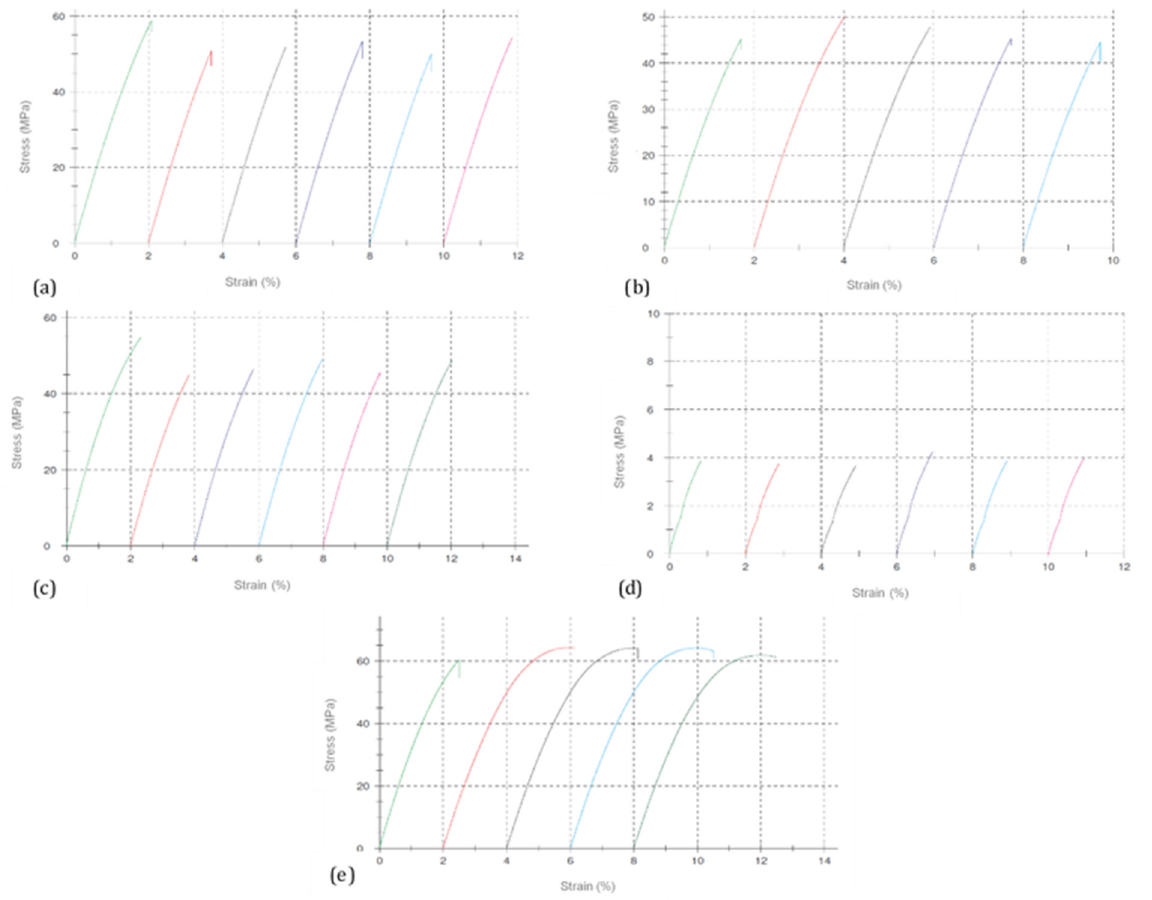
Figure 6. Tensile stress–strain curves of UPD90 ( a ), UPD85 ( b ), DPMD65 ( c ), UPMD65 ( d ), and UP2 ( e ).